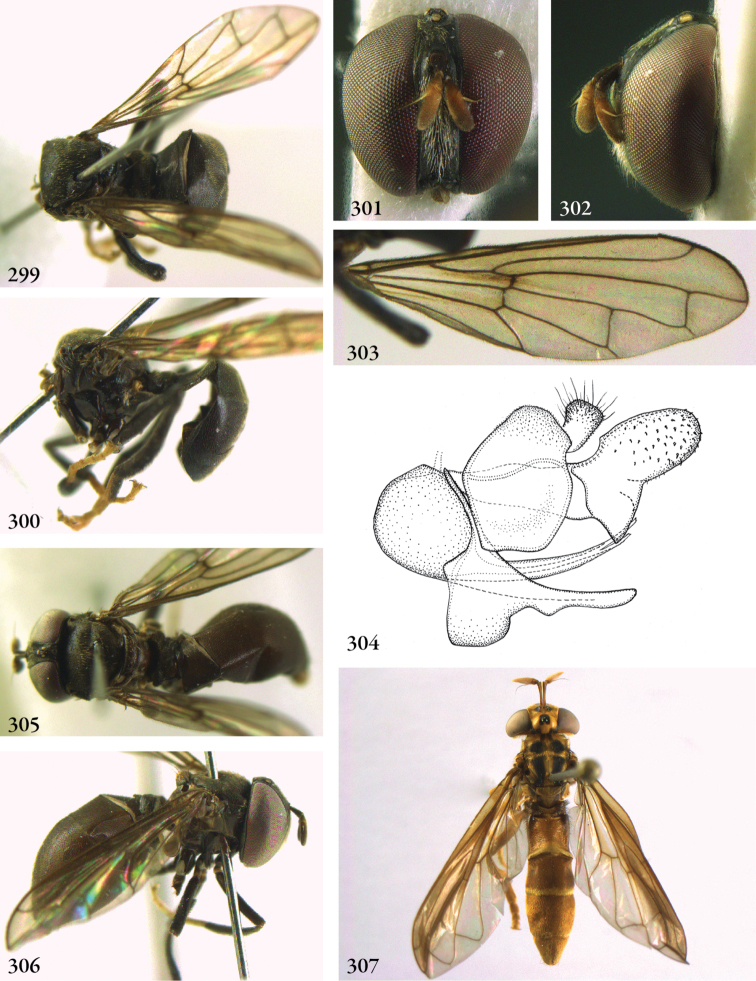
299–304
Piruwa phaecada male (holotype): 299 habitus dorsal 300 habitus lateral 301 head frontal 302 head lateral 303 wing 304 genitalia lateral 305–306
Piruwa phaecada female (paratype) 305 habitus dorsal 306 habitus lateral 307
Pseudomicrodon polistoides female (holotype), habitus dorsal.